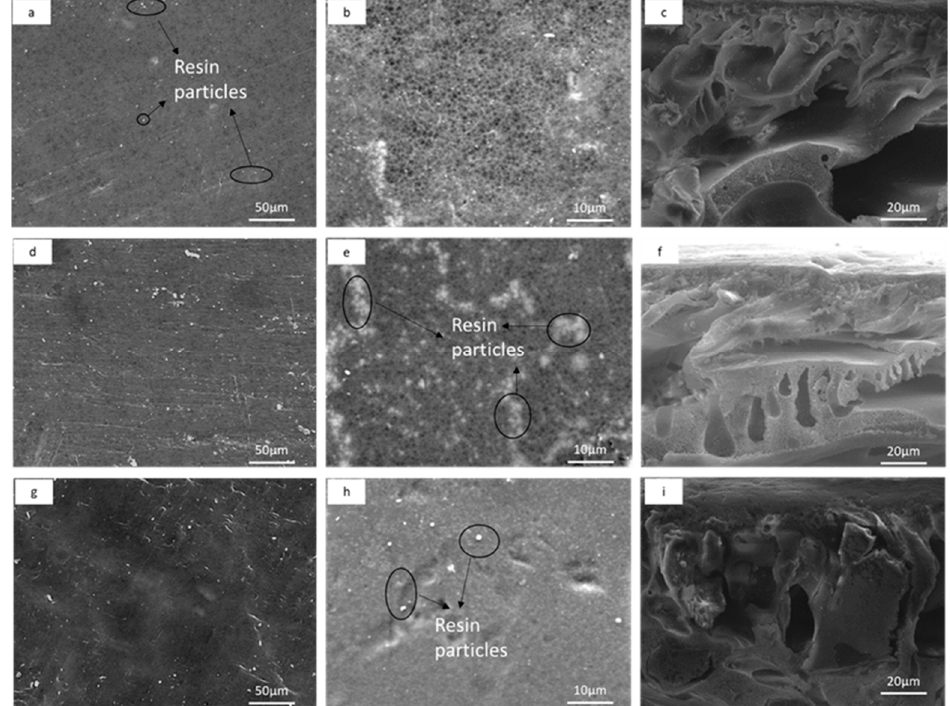
Figure 3. SEM images of custom-made UF heterogeneous AEMs: ( a ) surface images of AEM-1 at ×500, ( b ) surface images of AEM-1 at ×1000, ( c ) cross-sectional images of AEM-1, ( d ) surface images of AEM-2.5 at ×500, ( e ) surface images of AEM-2.5 at ×1000, ( f ) cross-sectional images of AEM-2.5, ( g ) surface images of AEM-3.5 at ×500, ( h ) surface images of AEM-3.5 at ×1000, and ( i ) cross-section images of AEM-3.5.